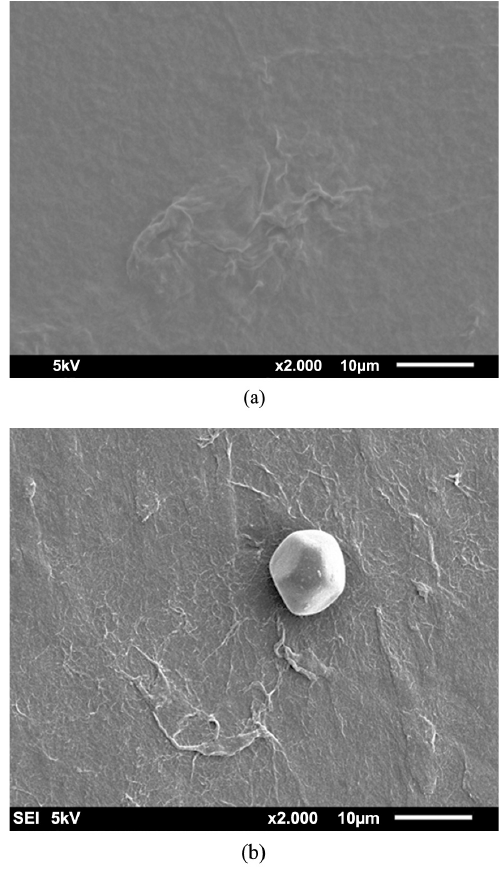
Figure 1. Micrograph of (a) standard BC and (b) blend of BC/starch membrane. 2000